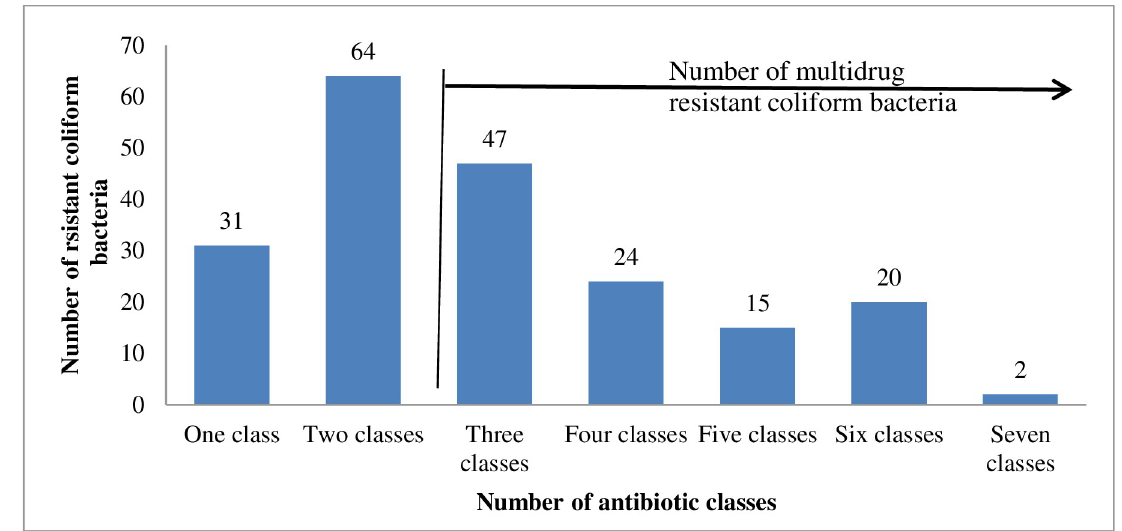
Fig 4. Number of resistant coliform bacterial isolates against number of antibiotic